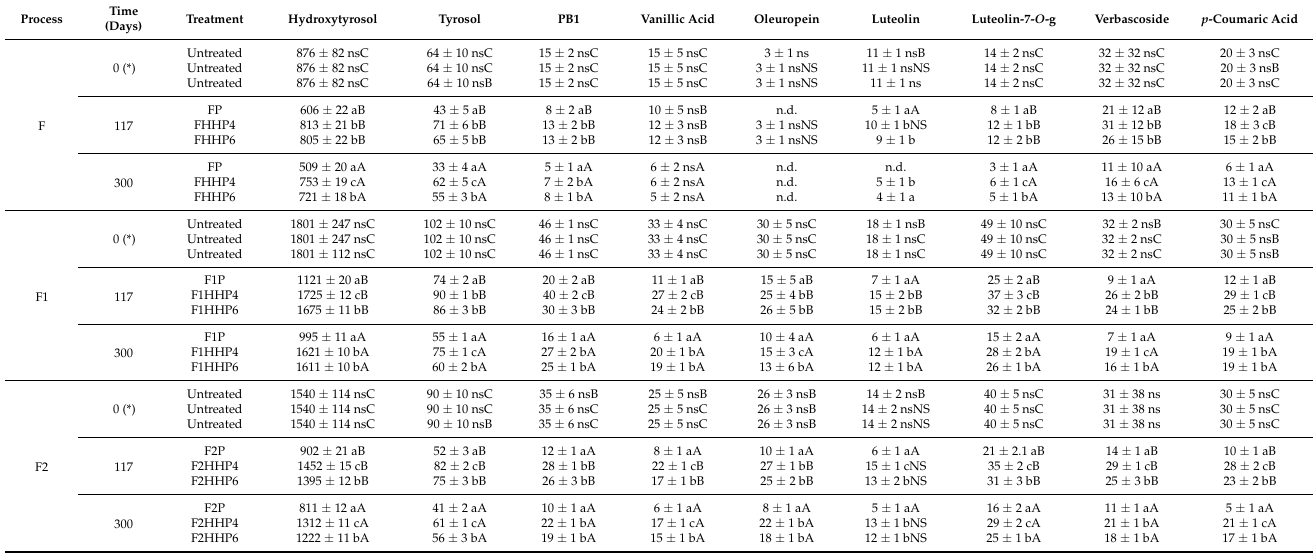
Table 3. Phenolic profile of table olives (mg kg − 1 ) during the storage period (mean ± standard deviation). F: spontaneous olive fermentation; F1: olives fermented with OLE + spontaneous fermentation; F2: olives fermented with OLE + S. cerevisiae; P: pasteurization treatment; HHP4: high hydrostatic pressure treatment (400 MPa, 4 min); HHP6: high hydrostatic pressure (400 MPa, 6 min).